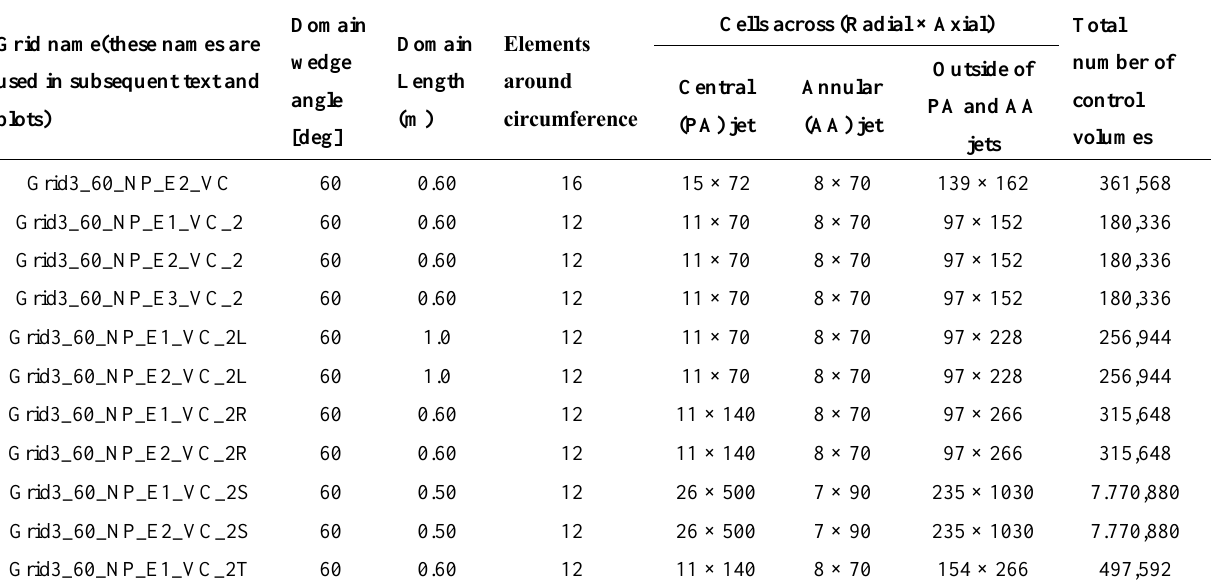
Table 3. A list of meshes used in the study, with key resolution